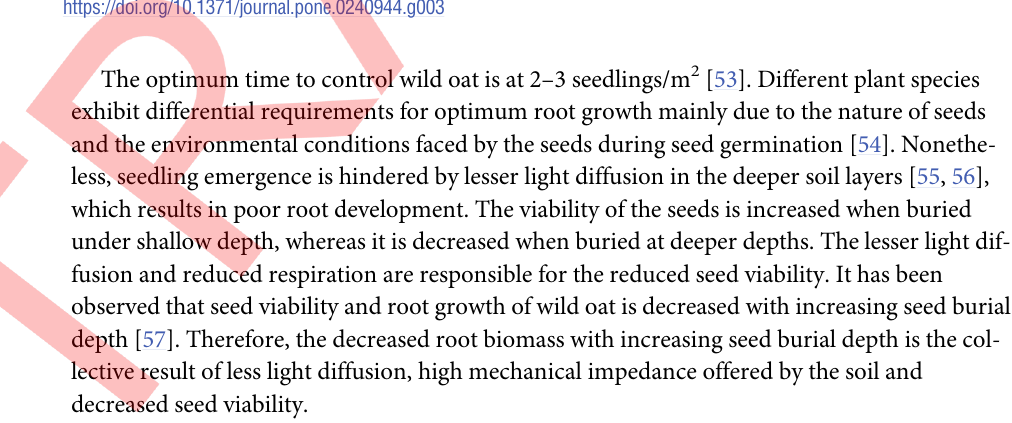
Fig 3. The effect of different wild oat and wheat density combinations on seed germination (A), number of tillers per plant (B), fresh weight (C) and dry weight (D) of wheat.